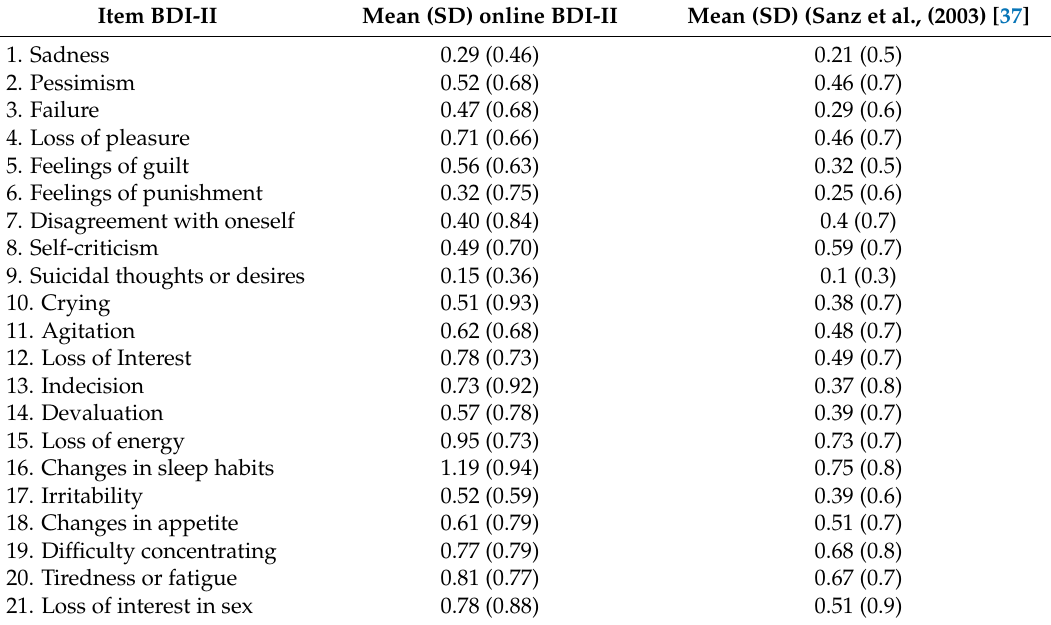
Table 8. Mean and standard deviation of BDI-II items versus a sample of adult (Sanz et al., 2003) [37]. Item